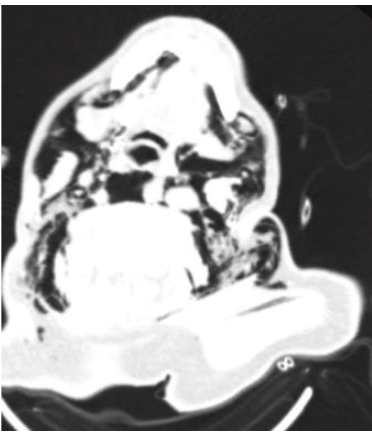
Figure 1: Extensive air density in all spaces of the suprahyoid neck region.